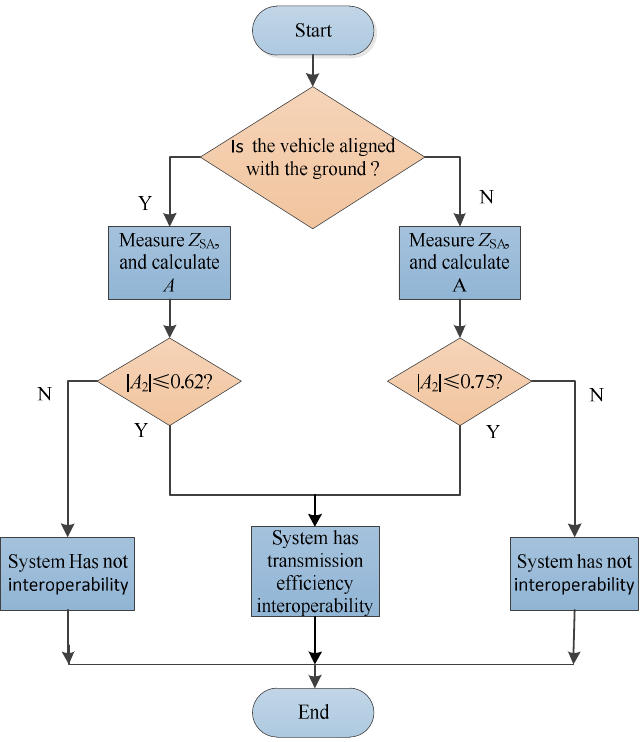
Figure 7. Flow chart of efficiency interoperability evaluation of WPT system for electric vehicles.